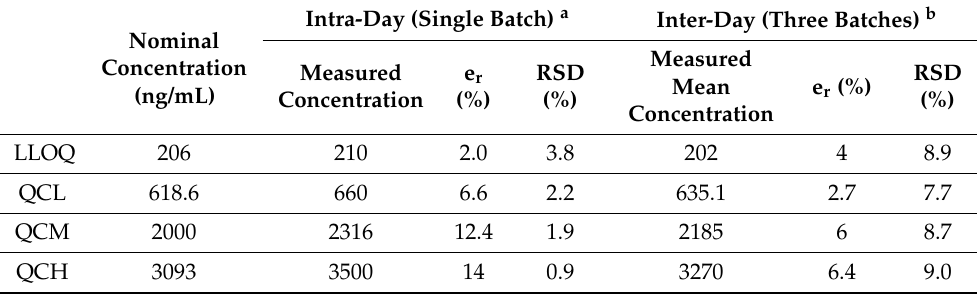
Table 6. Intra- and inter-day precision and accuracy of the method used for determination of capmatinib in